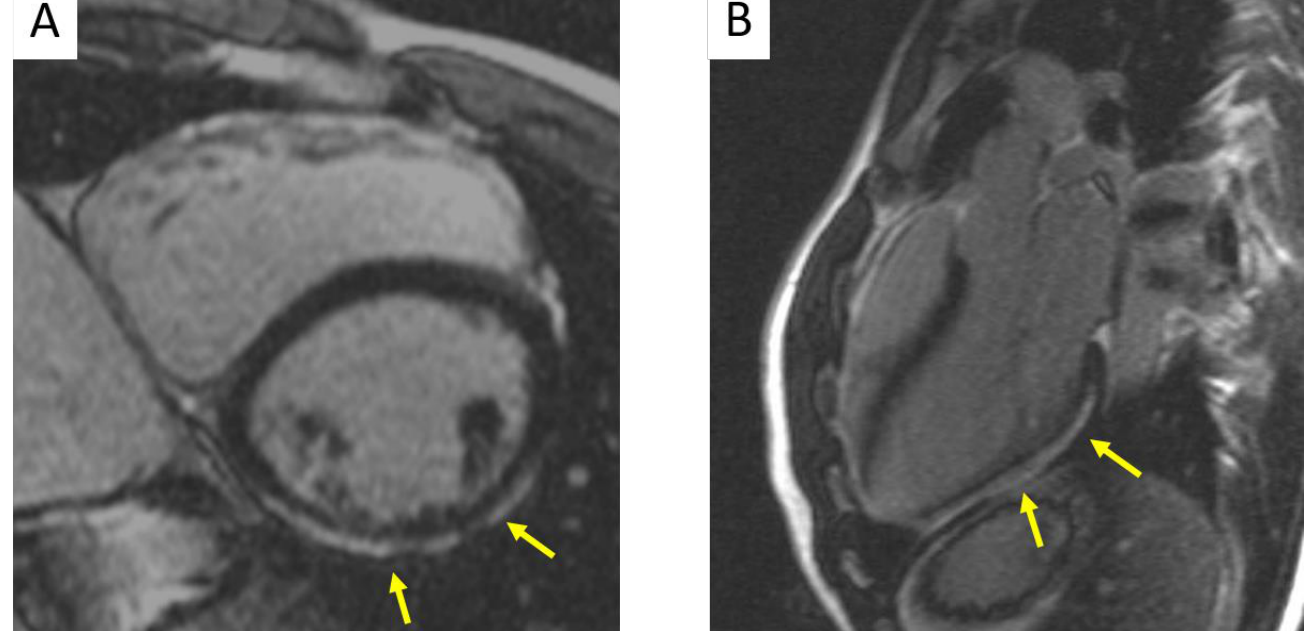
Figure 1. Cardiac magnetic resonance in a patient with a desmosomal gene related biventricular ACM showing the typical LV LGE pattern. ( A ) Short axis view demonstrating subepicardial LGE at the LV mid-inferolateral segments. ( B ) Three-chamber view exhibiting extensive LGE stria at the LV posterolateral wall. ACM=arrhythmogenic cardiomyopathy; LGE= late gadolinium enhancement; LV=left ventricle.